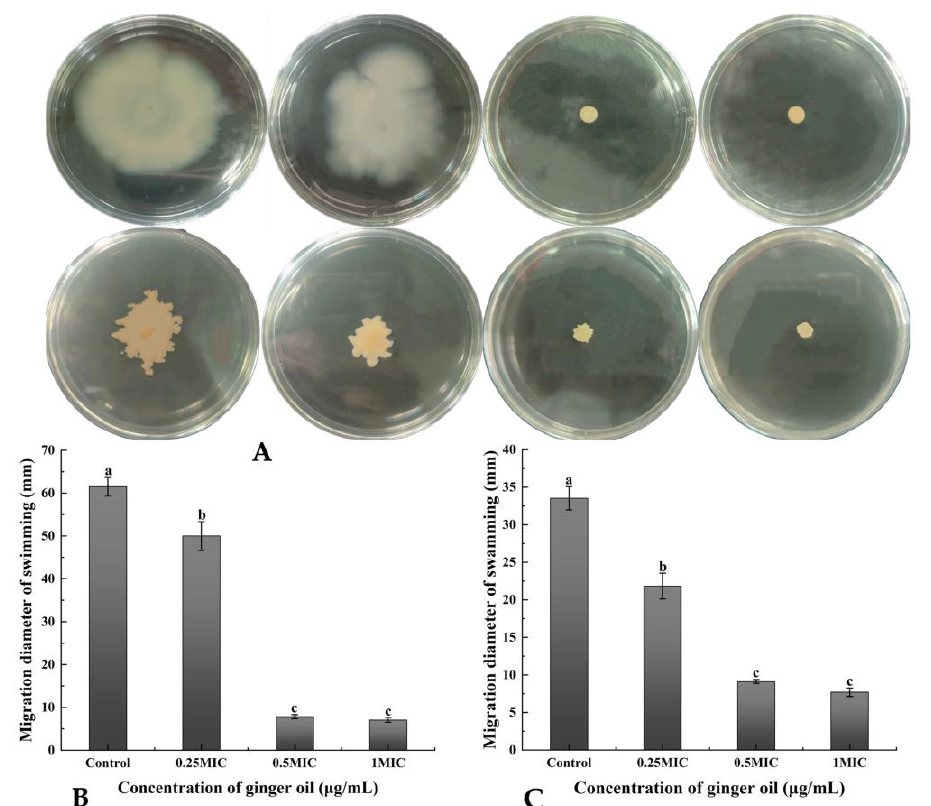
Figure 3. Analysis of ( A ) swimming and swarming photography, and the migration diameter of ( B ) swimming and ( C ) swarming. ( A ) indicates the growth curves of biofilms of S. putrefaciens at different GEO concentrations. ( A – C ) indicate changes in the motility of biofilms of S. putrefaciens with the change in GEO concentration. Different lowercase letters indicate significant difference ( p < 0.05).